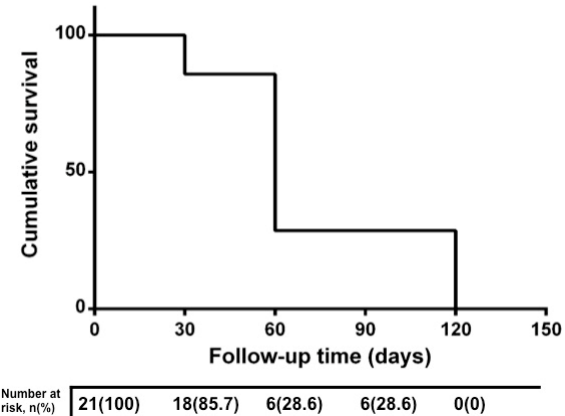
Figure 3. Kaplan–Meier curve of resolution rate during follow-up. Kaplan–Meier curve of resolution rate showing the timing of subretinal fluid reabsorption during 4-month follow-up.